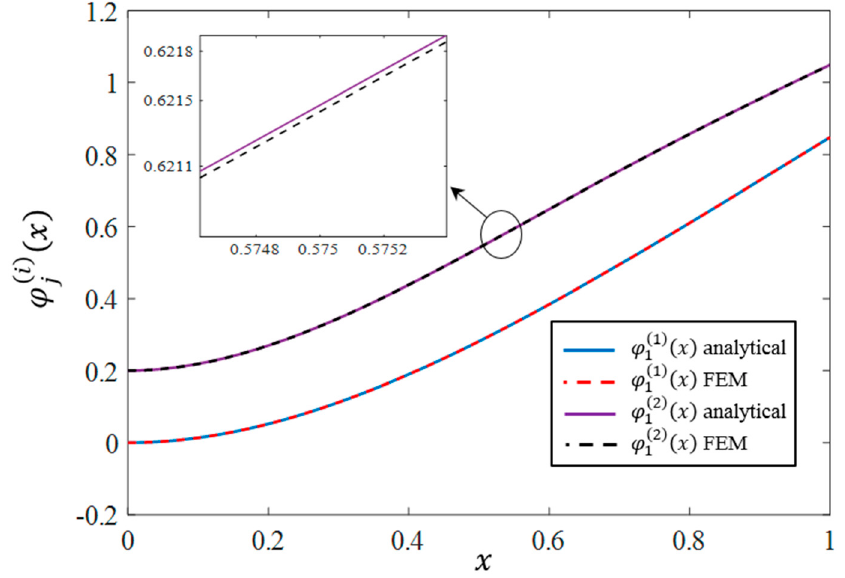
Figure 2. Comparison of the analytical and numerical shapes corresponding to the first mode.